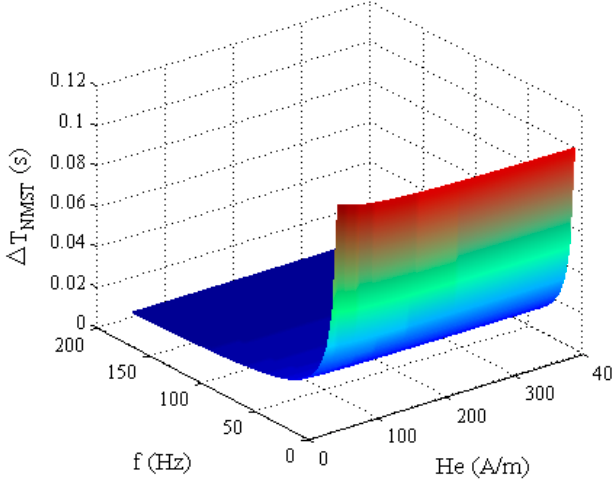
Figure 5. The relationship between Δ T NMST and H e ( t ).